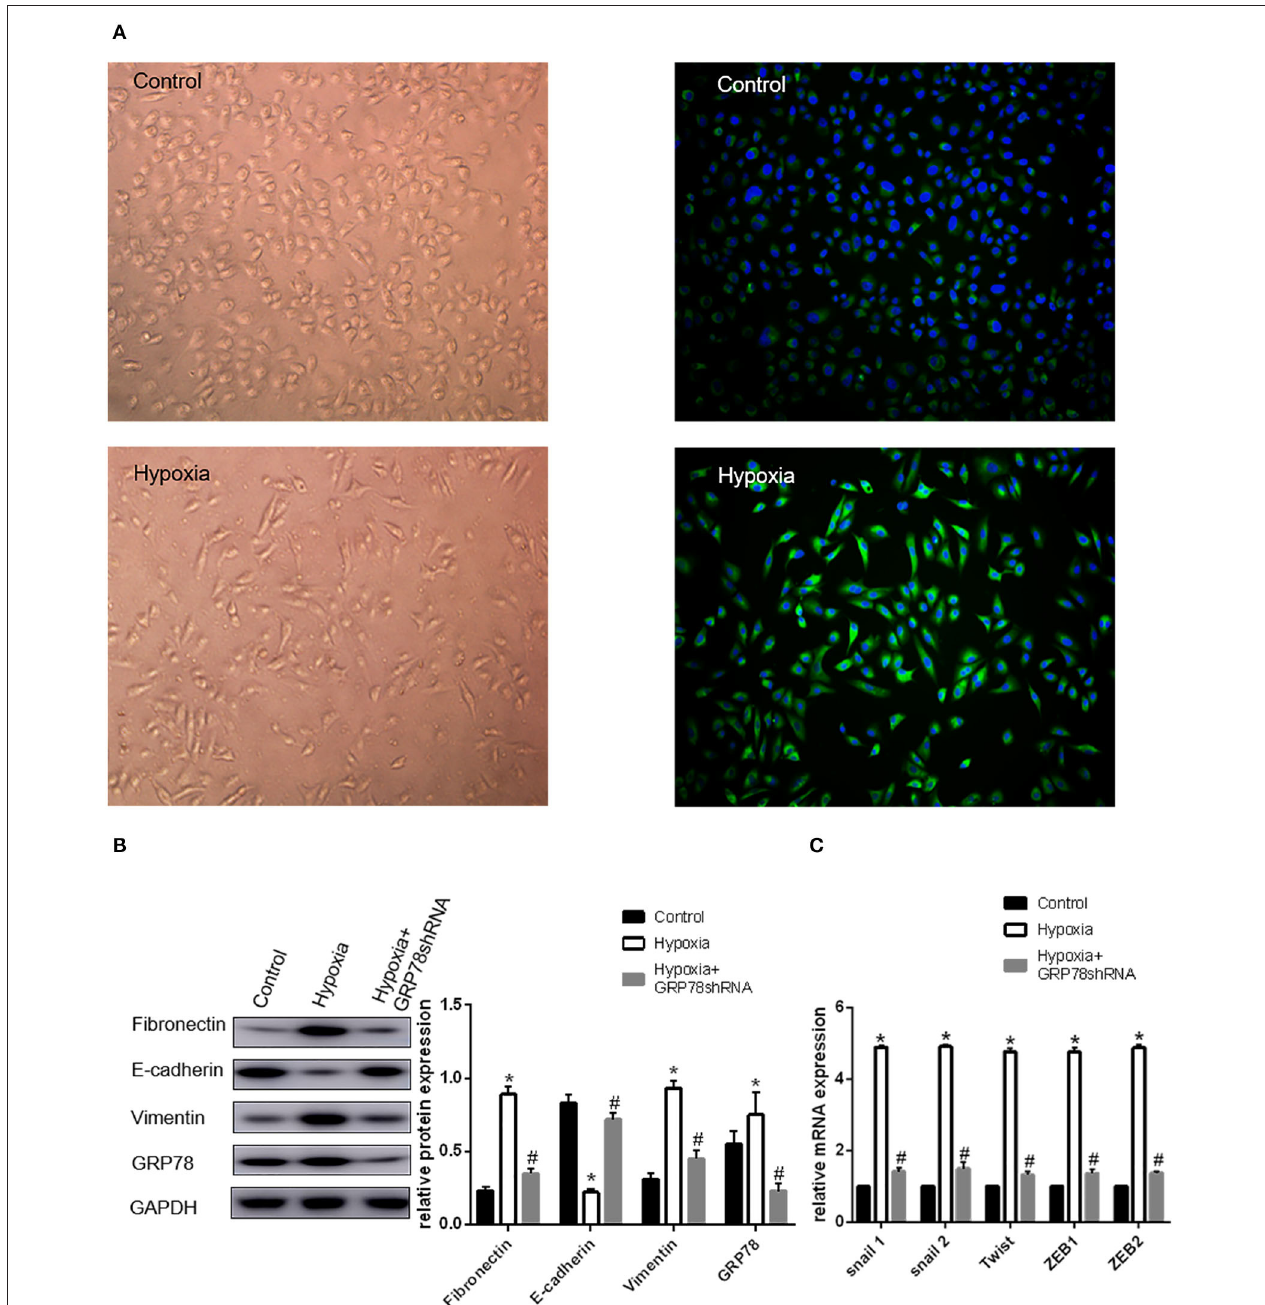
FIGURE 1 | Up-regulation of GRP78 plays an important role in hypoxia-induced EMT in A549 cells. (A) A549 cells acquire spindle-shaped mesenchymal morphology after 72h of 2% O 2 hypoxia (left, 100 × ). GRP78 (green fluorescence) is highly expressed in A549 cells with spindle-shaped mesenchymal morphology (right, 100 × ). (B) EMT-related markers (E-cadherin, Vimentin and Fibronectin) and GRP78 were examined by Western blot analysis (left). GAPDH was used as internal control. The protein relative value (GAPDH) is plotted in the right panel (mean ± SD in three separate experiments). * P < 0.05, compared with A549 cells under the condition of normal oxygen, the expression of E-cadherin decreases, while those of Vimentin and Fibronectin increase in A549 cells under hypoxia (2% O 2 72h). The expression of GRP78 also increases in A549 cells under hypoxia. # P < 0.05, compared with the A549 cells under the condition of hypoxia; the expression of E-cadherin increases, and those of Vimentin and Fibronectin decrease in GRP78 knockdown A549 cells under hypoxia. (C) EMT-related genes including Snail1, Snail2, Twist, ZEB1, and ZEB2 were examined by real-time quantitative PCR; mRNA expression relative value (control group) is plotted (mean ± SD in three separate experiments). * P < 0.05, compared with A549 cells in the control group, the mRNA expression levels of EMT-related genes including Snail1, Snail2, Twist, ZEB1, and ZEB2 increase under hypoxic condition (2% O 2 72h); # P < 0.05, compared with A549 cells under the condition of hypoxia, the mRNA expression levels of EMT-related genes decrease in GRP78 knockdown A549 cells under